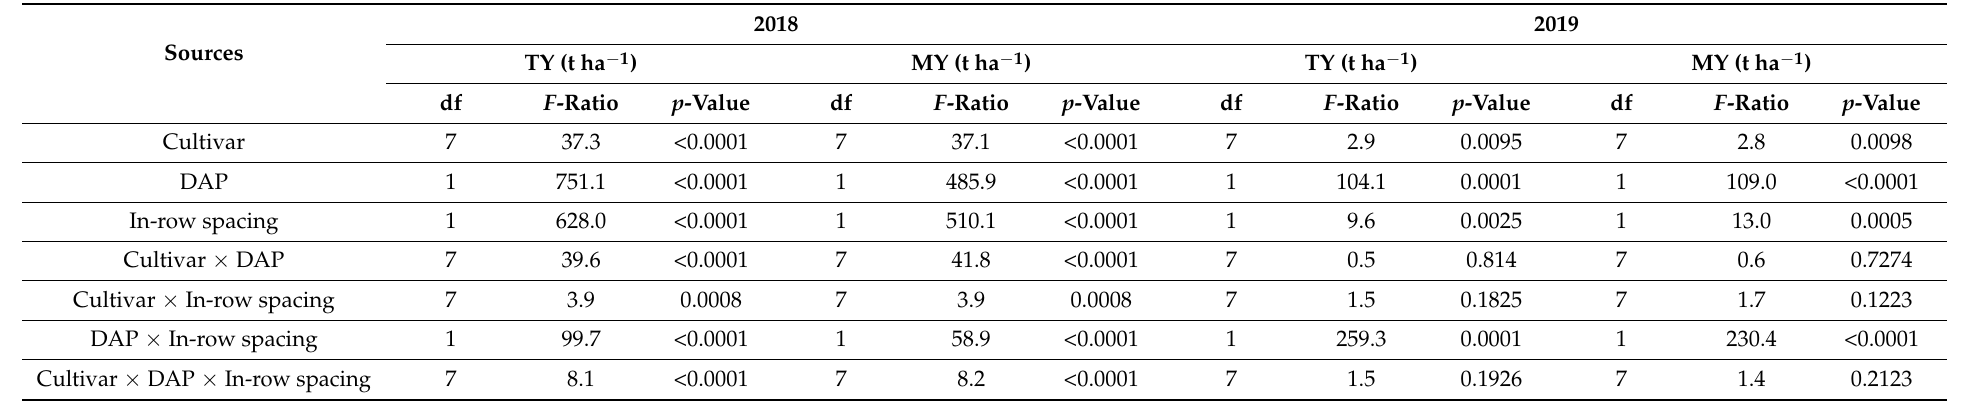
Table 2. Analysis of variance F -ratio results for total yield (YT) and marketable yields (MY) for variety, days after planting (DAP), in-row spacing, and interactions effects for the 2018 and 2019 growing seasons at Rock Springs, PA.